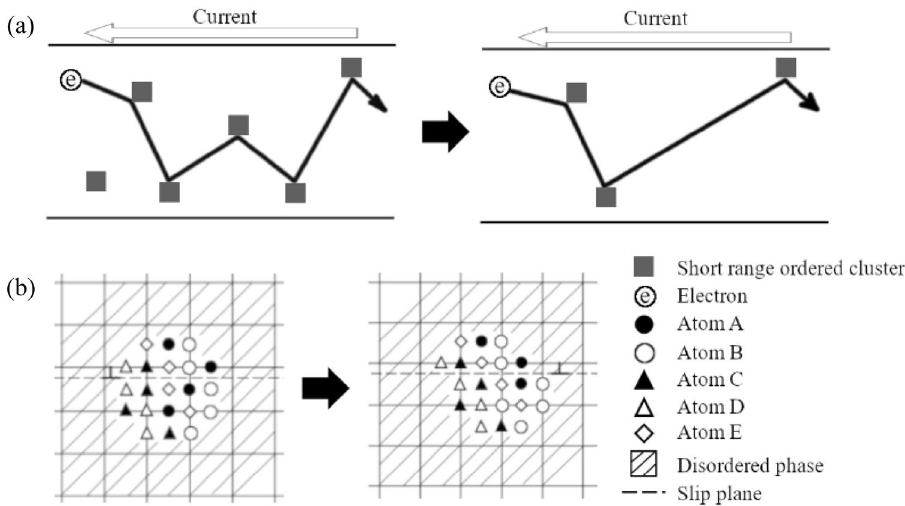
Figure 5. Schematic diagram of a binary alloy. ( a ) scattering of free electrons by short range ordered domains and ( b ) cut of short range ordered domain by dislocation due to plastic deformation. It is the modification from the binary alloy case 31